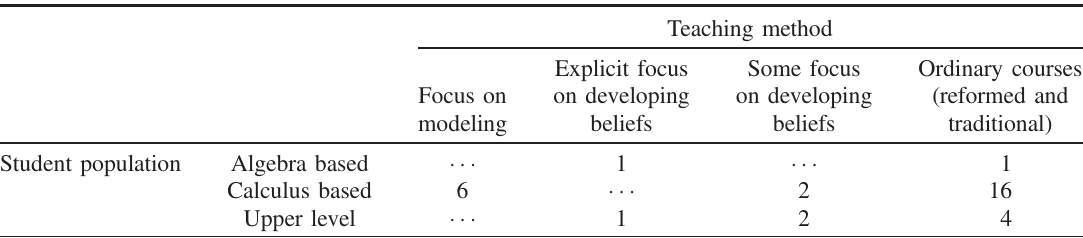
TABLE IV. Number of courses for each combination of teaching method and student population, “ (cid:2) (cid:2) (cid:2) ” indicates no courses have a given combination.